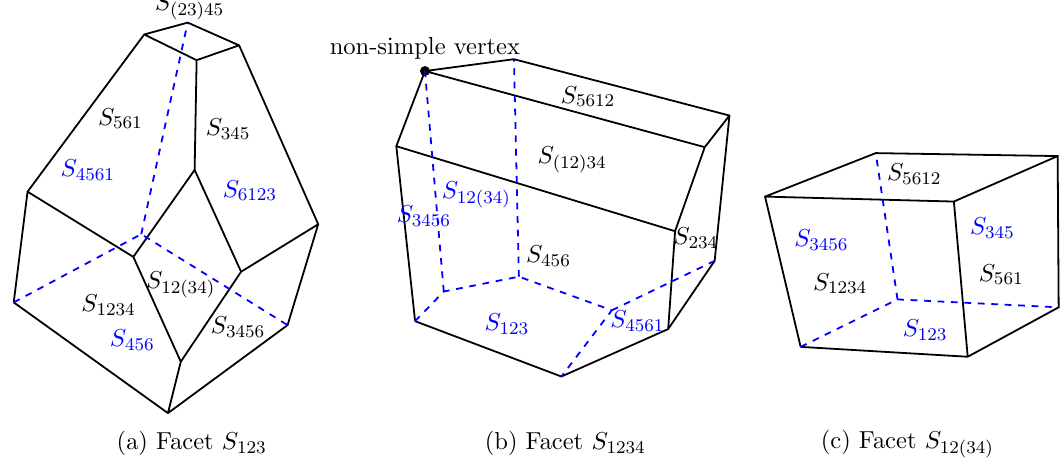
Figure 3 . Three kinds of facets in P (3 ; 6). Here a 2-plane is an intersection of two facets. For example, the bottom square in (a) is the intersection of facets S 456 and S 123 .